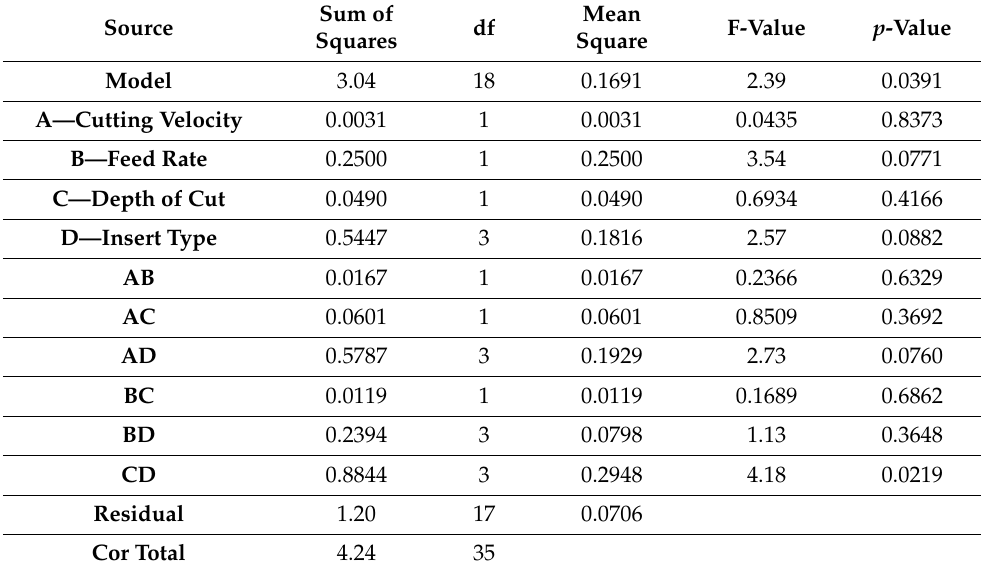
Table 6. ANOVA for the response-surface quadratic model surface roughness for cutting